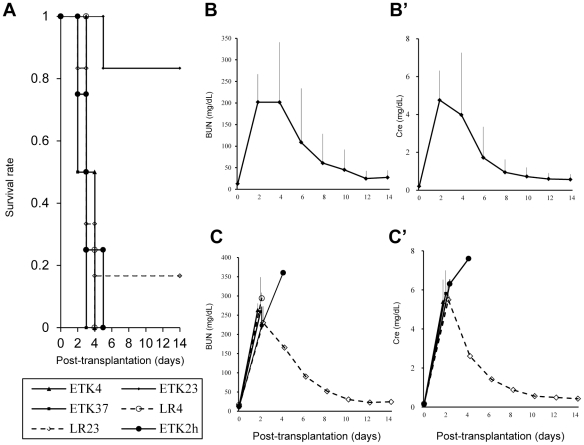
Survival rate, blood urea nitrogen (BUN) and serum creatinine (Cre) levels in experiment 2.(A): Survival rate of each group. Survival rate of the group receiving kidneys preserved with ET-Kyoto solution (ETK) for 1 h at 23°C (ETK23 group) was significantly longer than that of the other groups (# p<0.01 using Log-Rank test.). (B): BUN and (B'): Cre of the ETK23 group. (C): BUN and (C'): Cre of the other groups without EK23. In all groups in experiment 2, BUN and Cre of all surviving rats reached a peak at day 2 and recovered to a nearly normal range by day 14. (BUN and Cre of the LR23 group was n = 1 after day 4.)